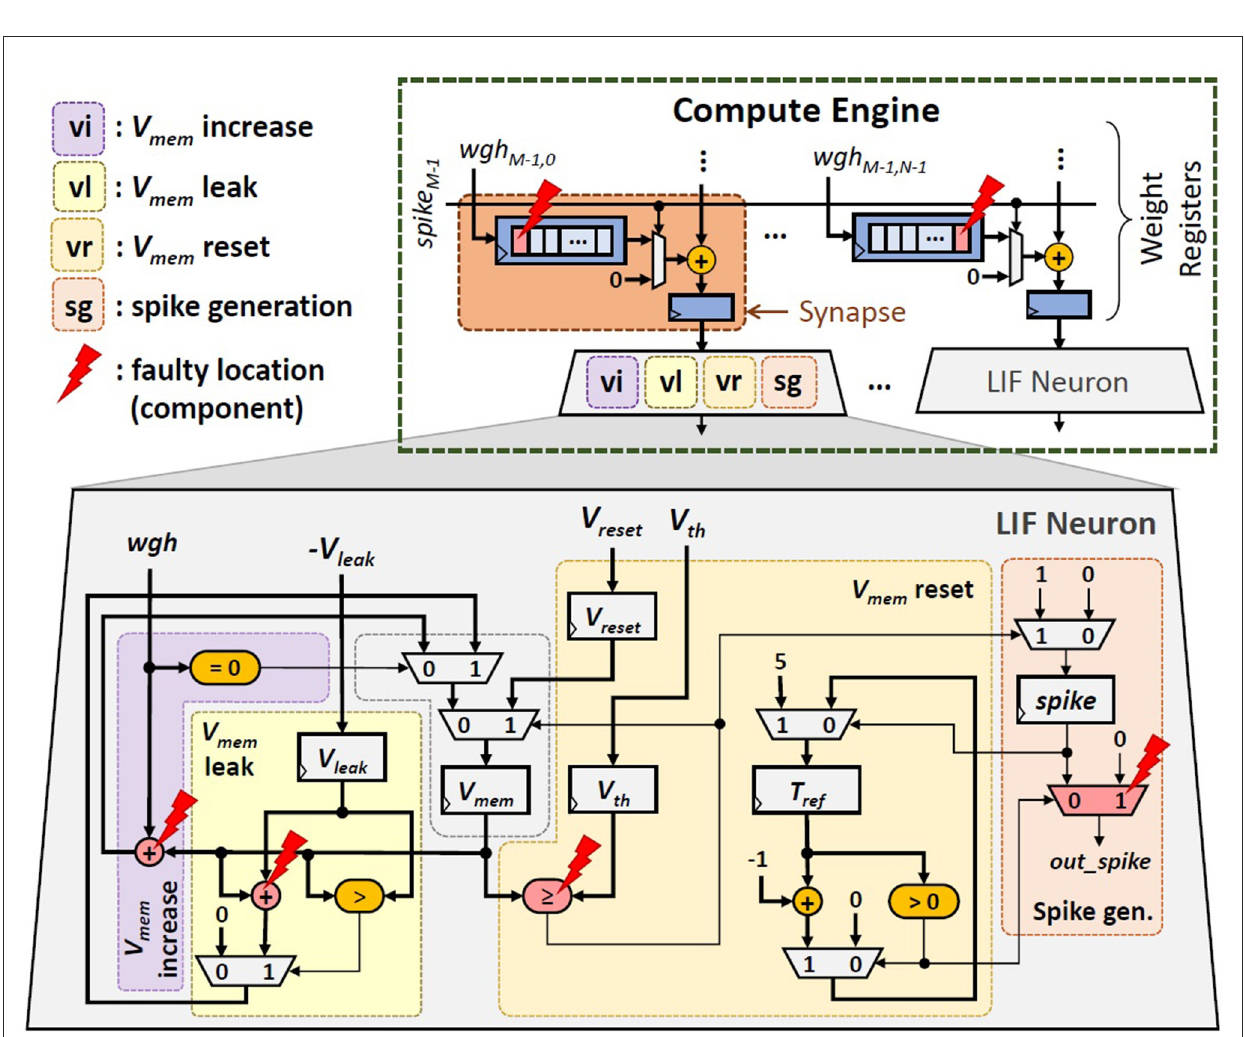
FIGURE13 The potential locations/components that can be affected by permanent faults to cause faulty memory cells as well as faulty ‘ V mem increase’, ‘ V mem leak’, ‘ V mem reset’, and ‘spike generation’